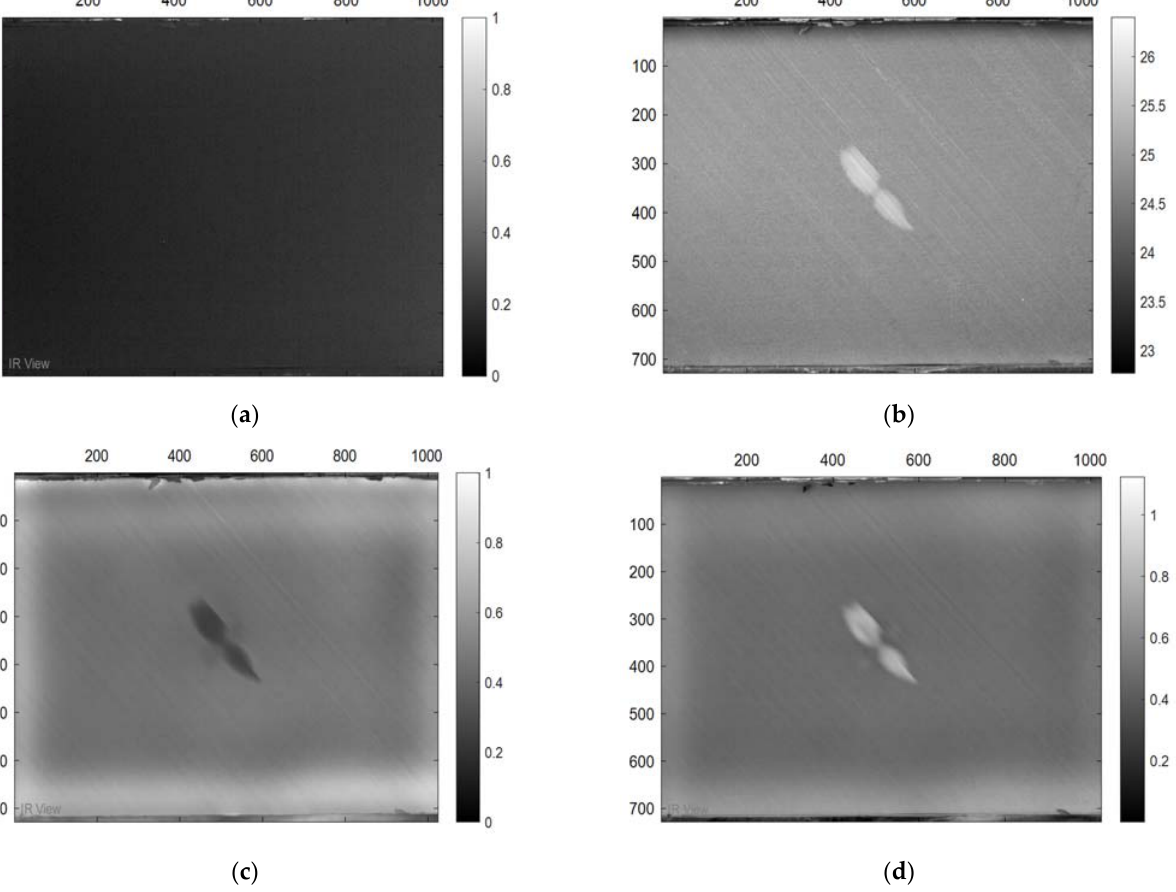
Figure 3. Images Processing Results, ( a ) raw thermogram corresponding to t = 0.8 s. ( a ) Cold image. ( b ) Raw Image. ( c ) BCT Image. ( d ) PPT Image.